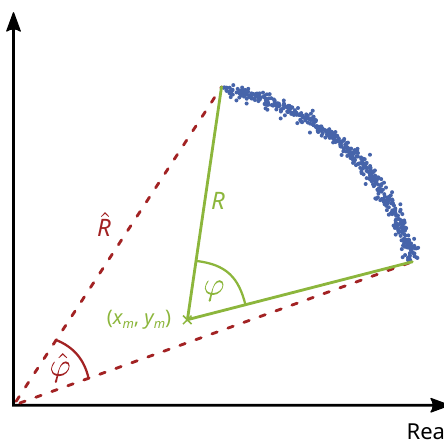
Figure 4. Phasor plot of the circular arc of a moving target with radius R and central angle ϕ superimposed with a static target. The static target adds a systematic deviation to the origin ( x m , y m ) of the circular